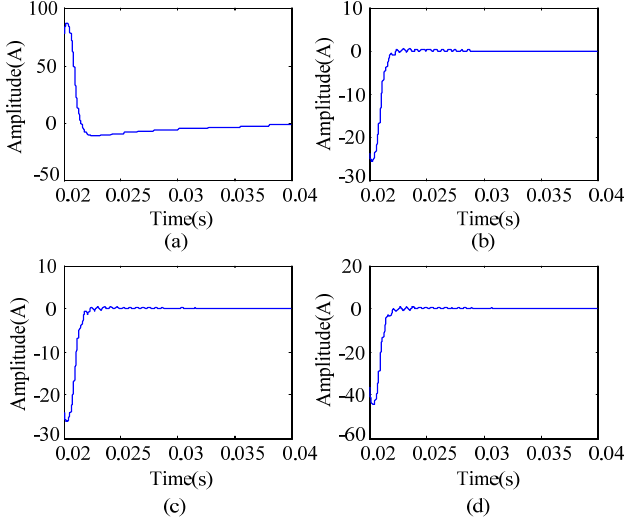
Figure 11. NPFCs after smoothing. ( a ) Lian L 1 ; ( b ) Lian L 2 ; ( c ) Lian L 3 ; ( d ) Lian L 4 .